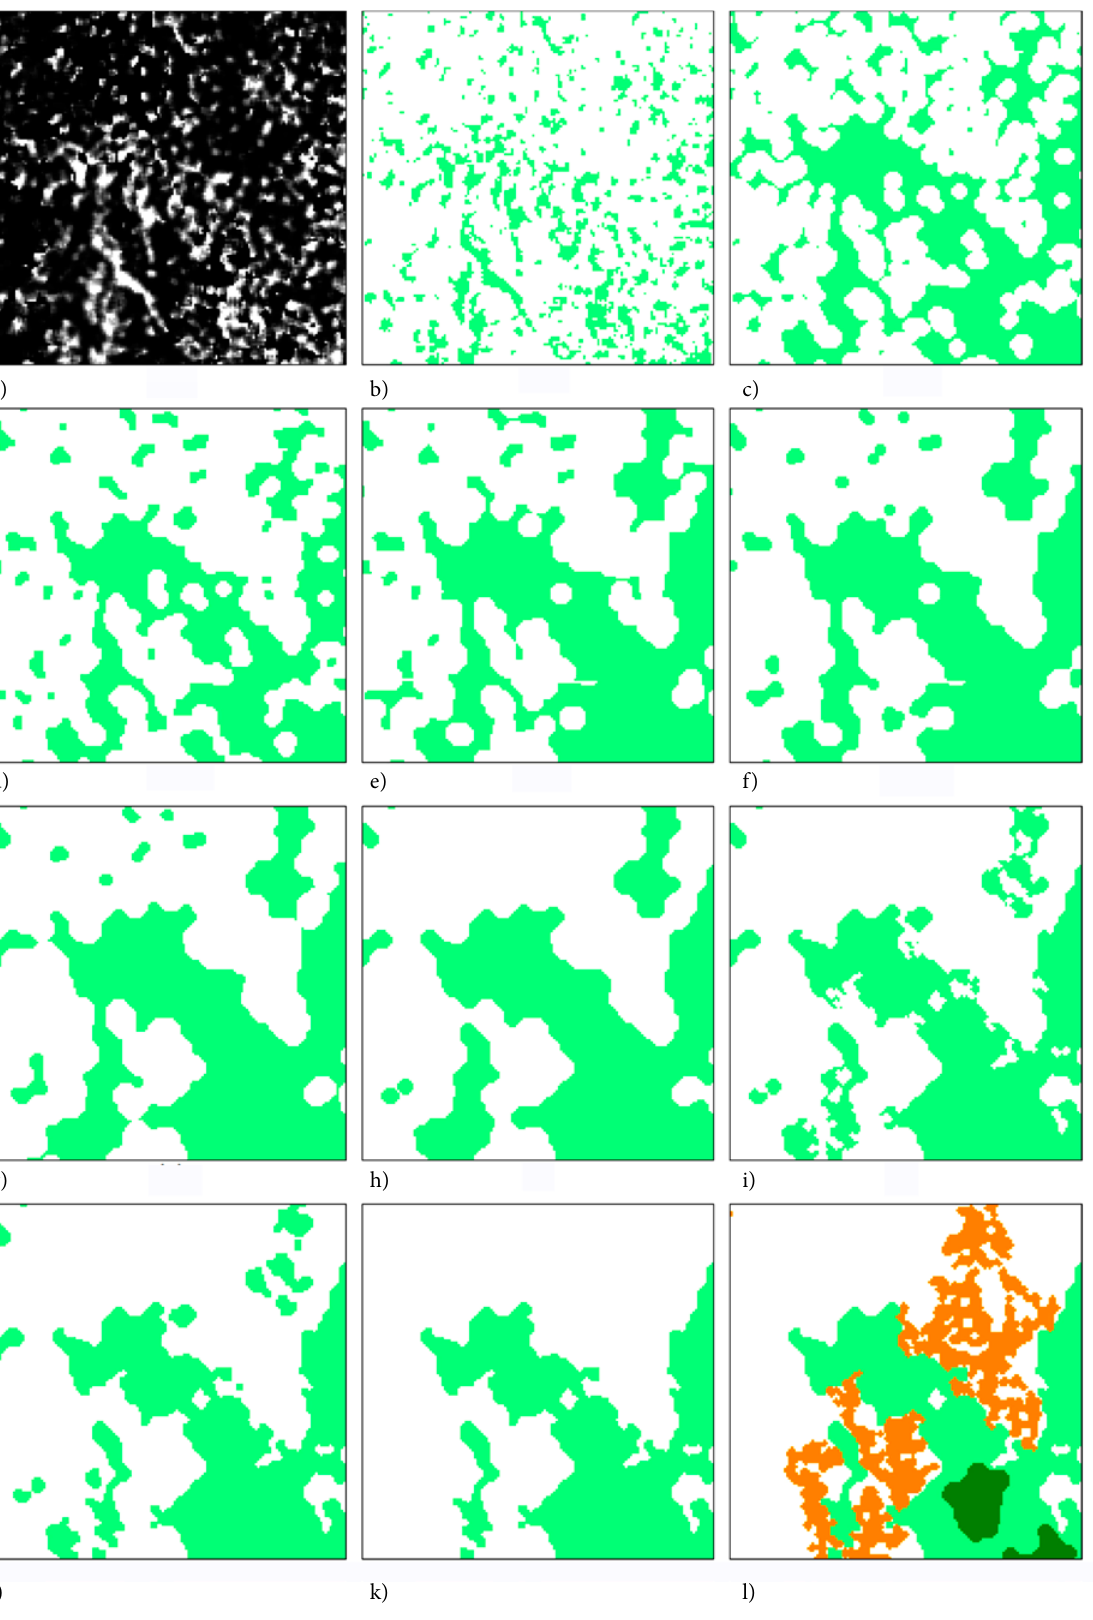
Fig. 7. Results of processing steps in the mapping of areas with reduced runability due to forest tree vegetation (a–k). The combined mapping of open areas and reduced runability (l). Pixel size = 1.5 m, image portion size = 225 m × 225 m. For the explanation of each step (a–l), see Sections 2.2 and